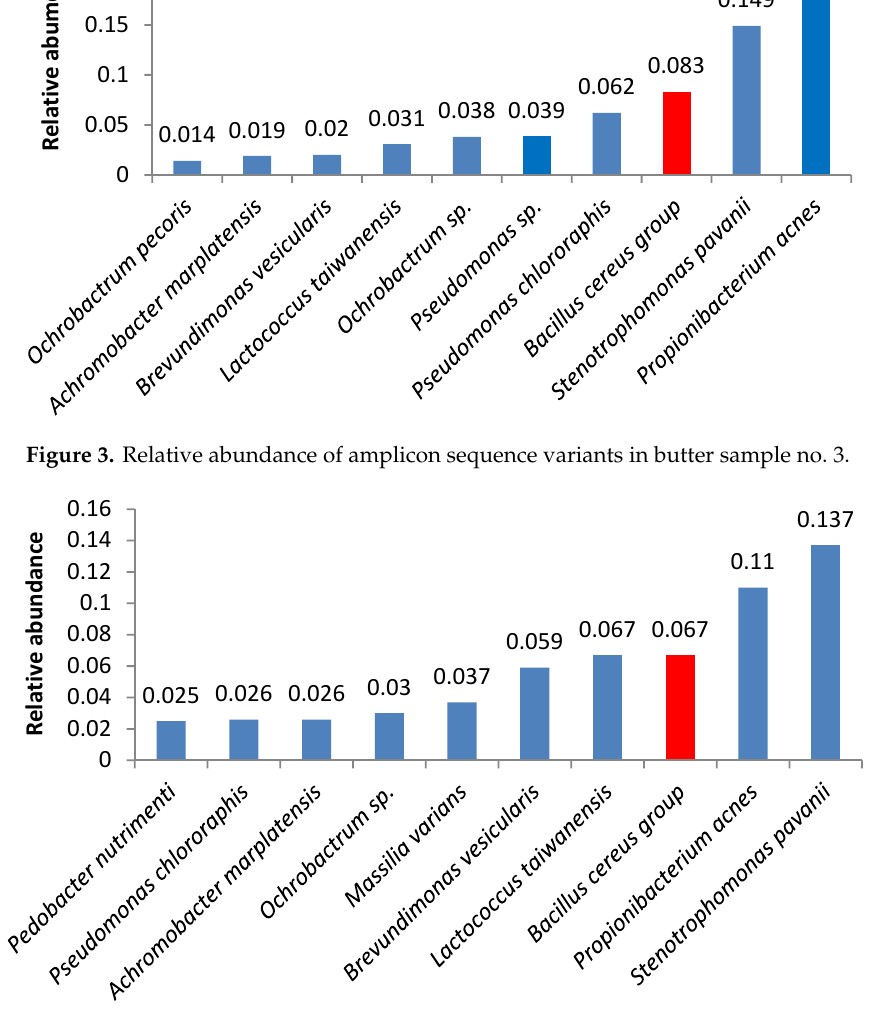
Figure 4. Relative abundance of amplicon sequence variants in butter sample no. 18.